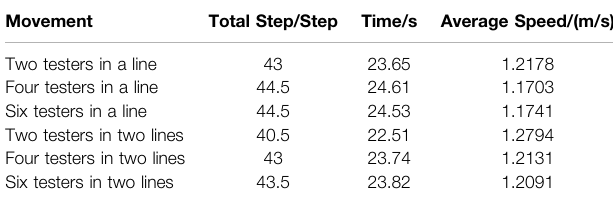
TABLE 9 | Experimental data of synchronized multi-person walking.